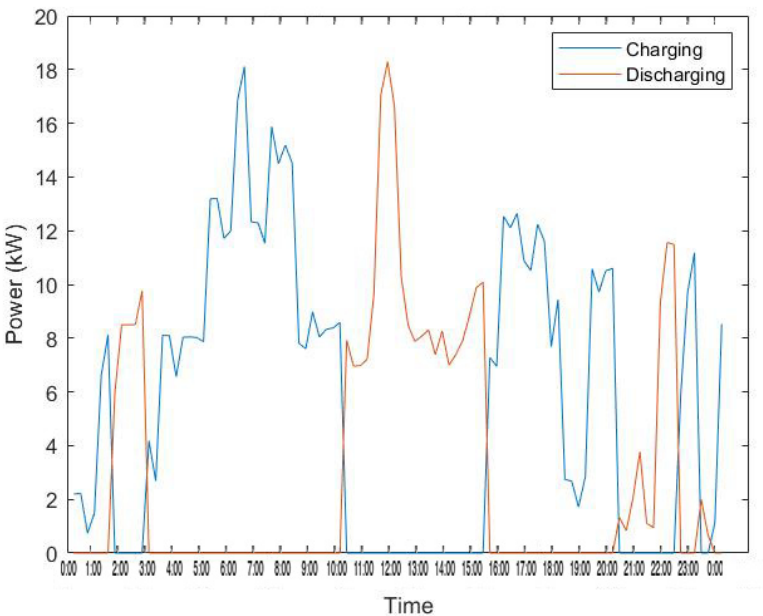
Figure 18. Charging and Discharging of Street Battery in PCLU.